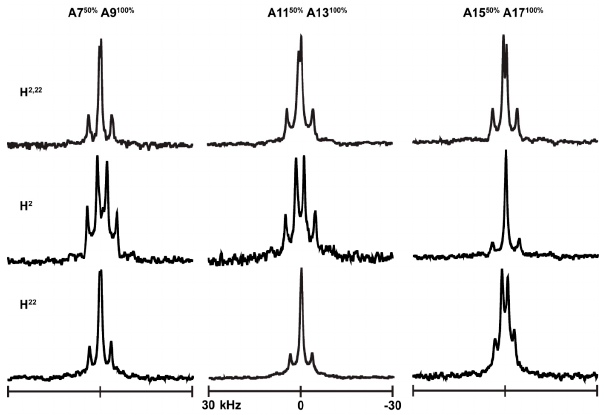
Figure 2. 2 H NMR spectra of H 2,22 WALP23, H 2 GWALP23 and H 22 GWALP23in DOPC lipid bilayers.